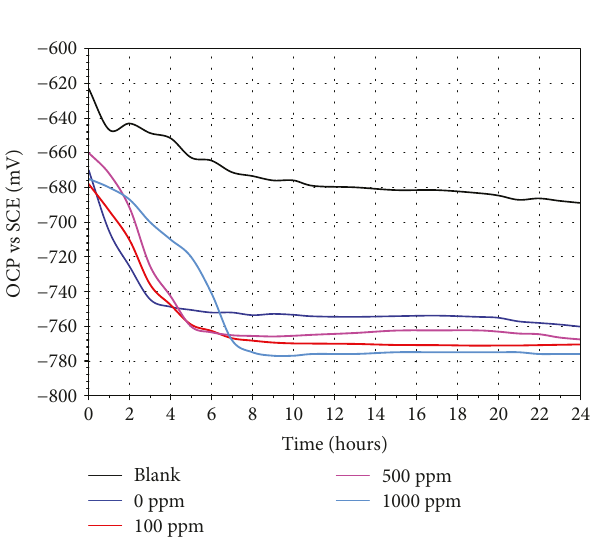
Figure 9: OCP values for 1018 carbon steel bare and coated with chitosan doped with